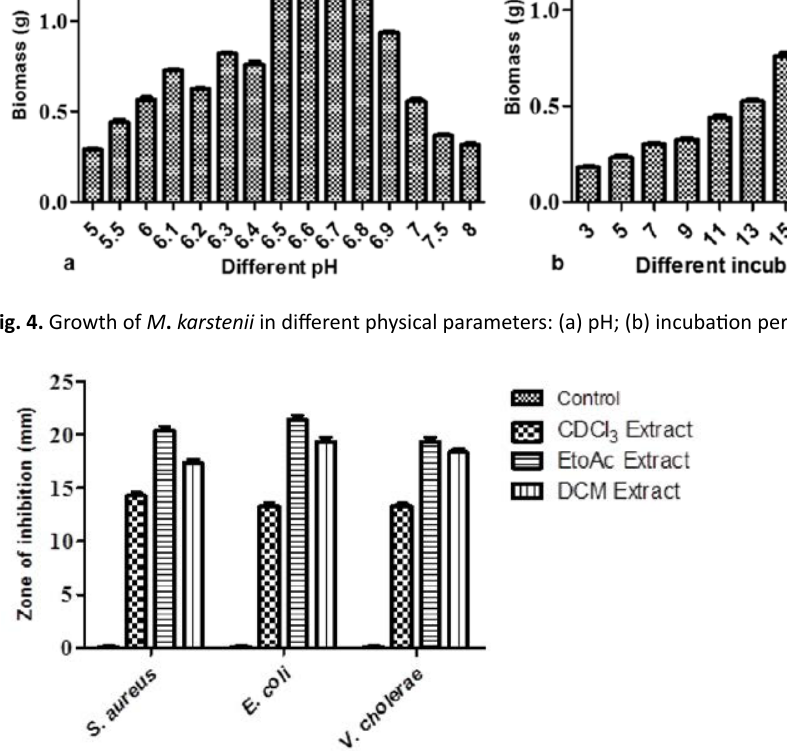
Fig. 5. Antibacterial activity of different solvent extracts of M . karstenii ; control – 0.4% DMSO; CDCl chloroform; EtoAc extract - ethyl acetate; DCM extract